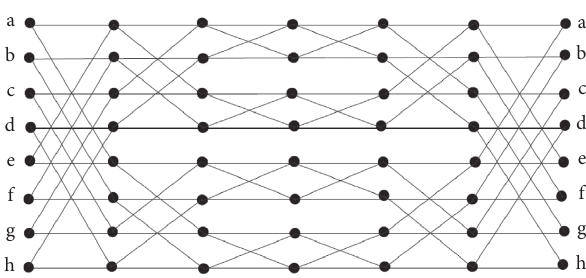
Figure 3: 3D vertical cylindrical Benes network.